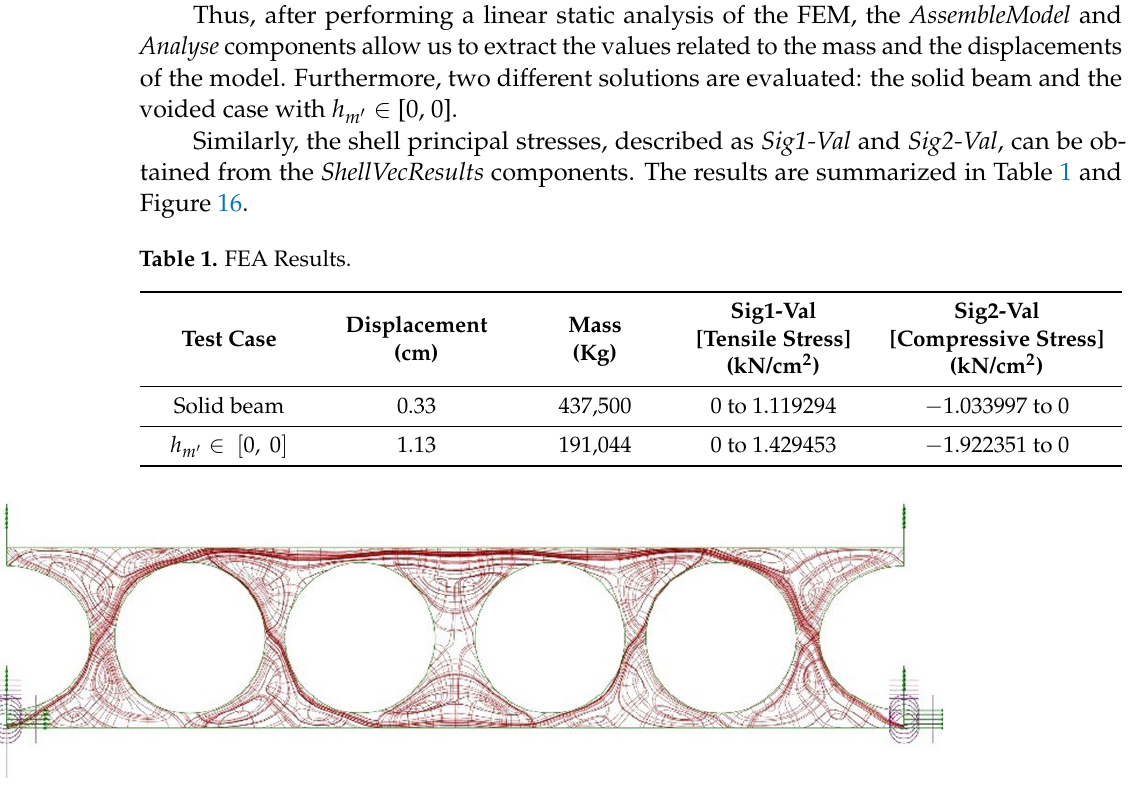
Figure 16. Sig1-Val and Sig2-Val path.